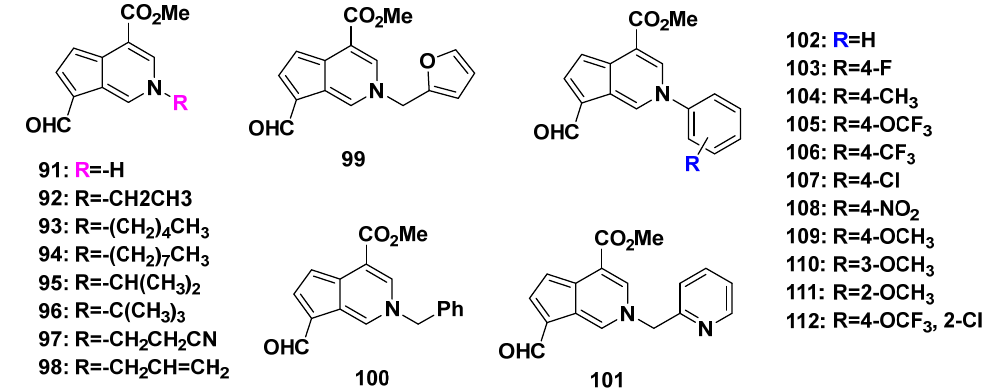
Figure 8. Cyclopenta[c]pyridine products ( 91–112 ) obtained from a concise biomimic access.